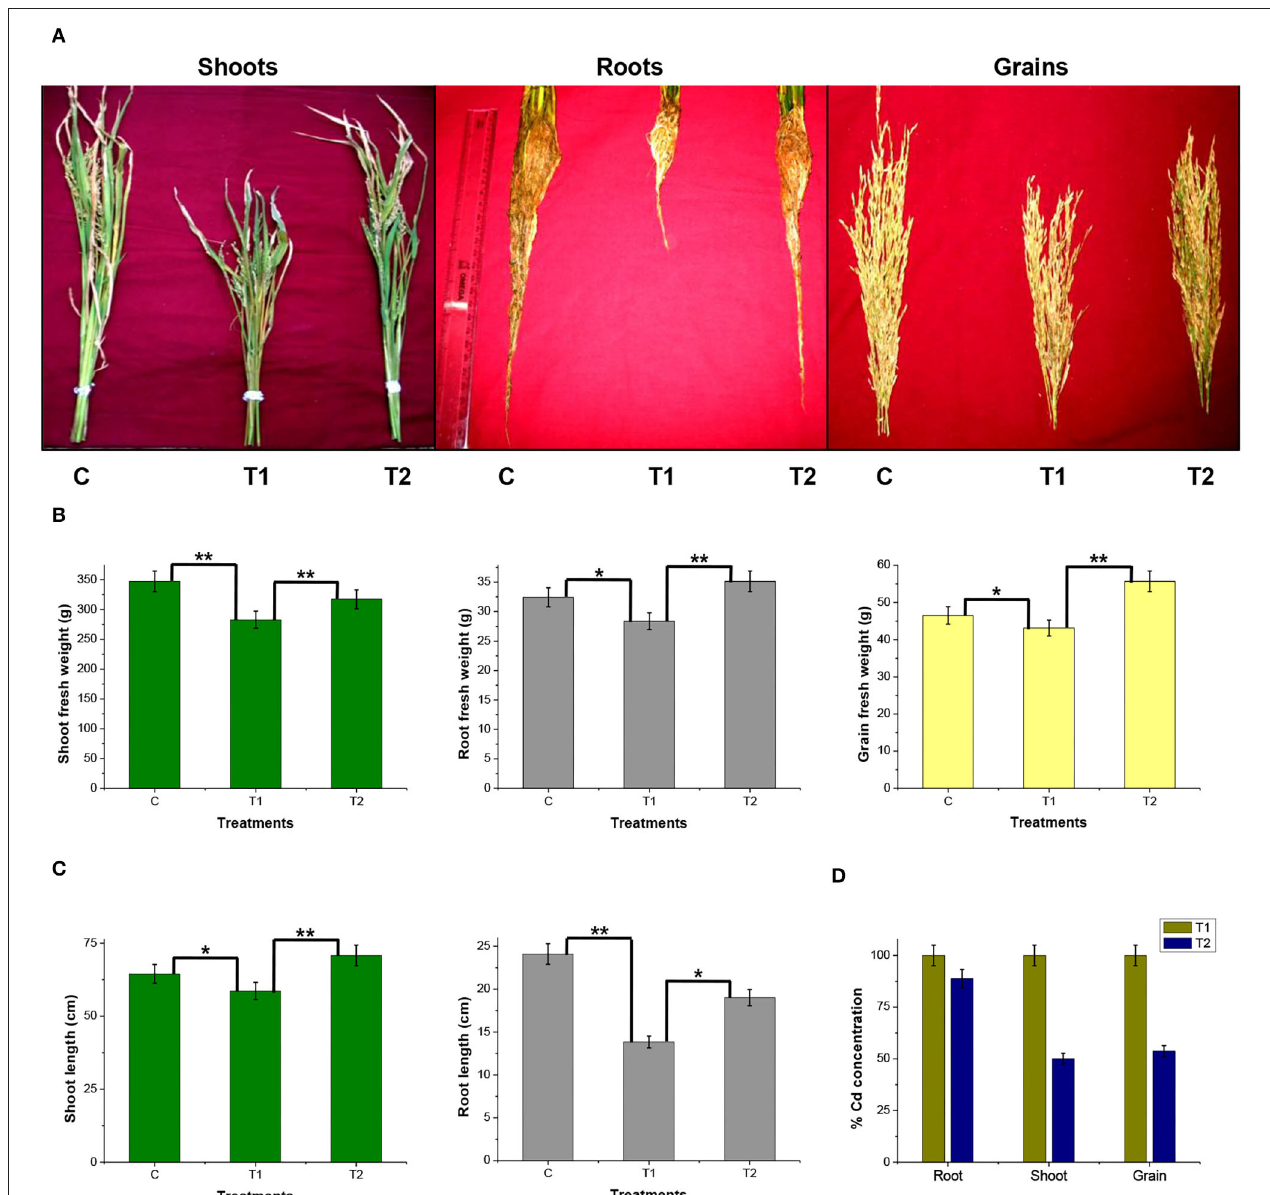
FIGURE 5 | Effect of P. rettgeri on different growth parameters of the rice plant. (A) The images show shoots, roots, and grains of rice plants harvested at the maturity stage (135 days). (B) Fresh weight of or (C) length of or (D) the Cd concentration in the shoots, roots, or the grains harvested from the rice plants at the maturity stage. Details of C, T1, and T2 are the same as given in Figure 4 . The values represent means obtained from three replicates, and the bars represent the standard deviation of means. Comparisons of individual groups were carried out using the post-hoc Tukey’s test. The p -values were obtained using the post-hoc Q table. * α ≤ 0.05, i.e., 95% CI; ** α ≤ 0.01, i.e., 99% CI based on Tukey’s mean grouping. Cd content in control plant tissues was below detectable